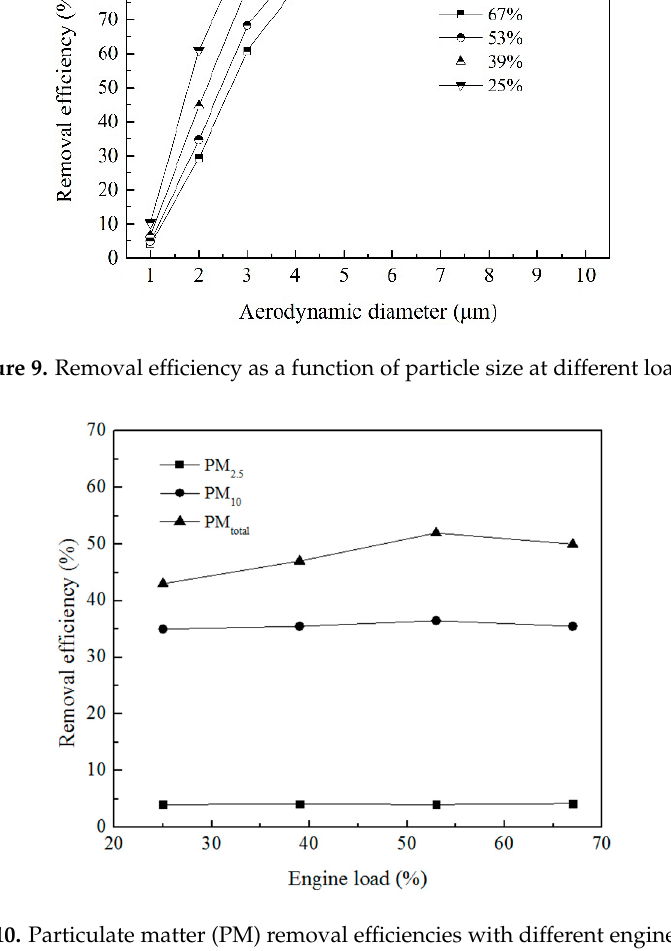
Figure 10. Particulate matter (PM) removal efficiencies with different engine loads.